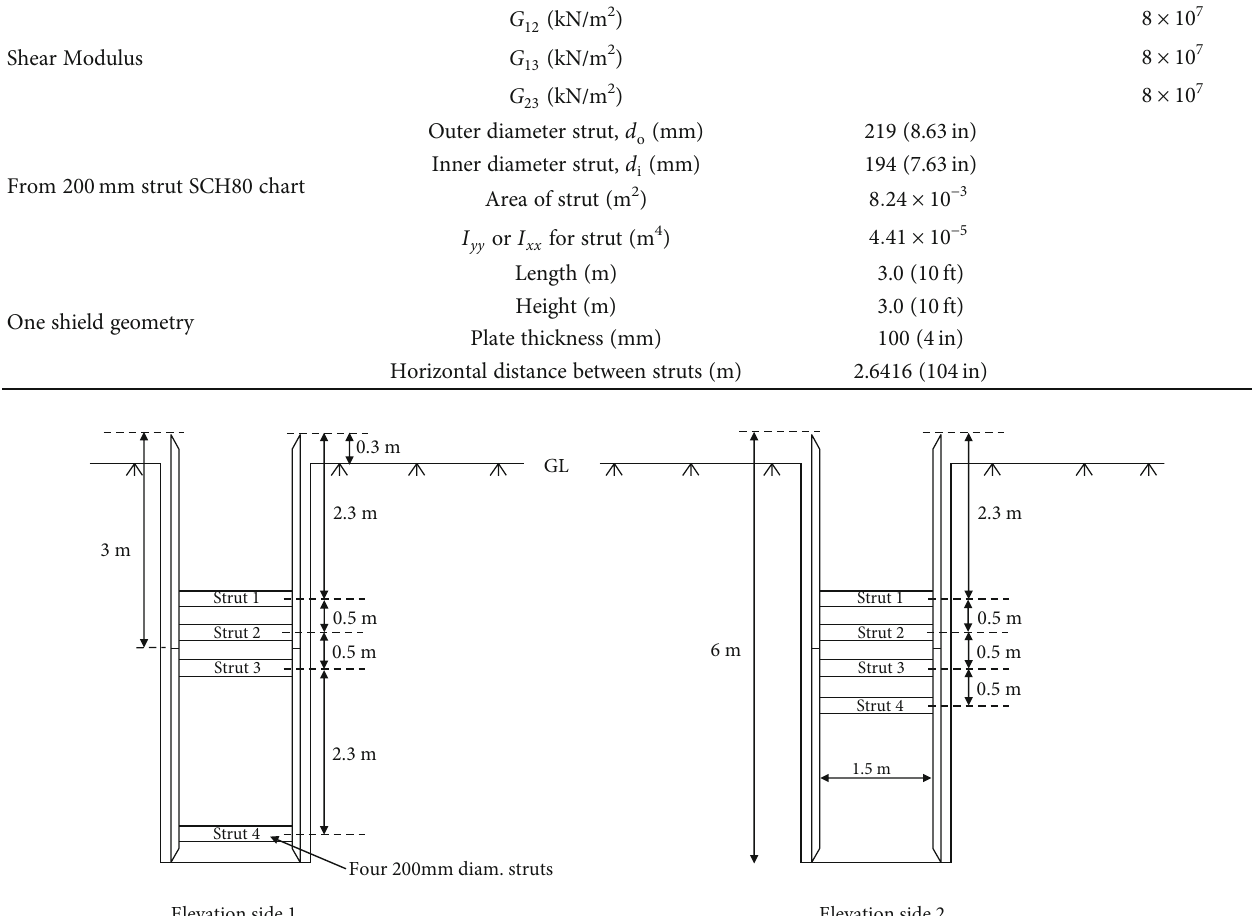
Figure 3: Strut spacing and locations in the two assembled box shields (stacked upon each other).